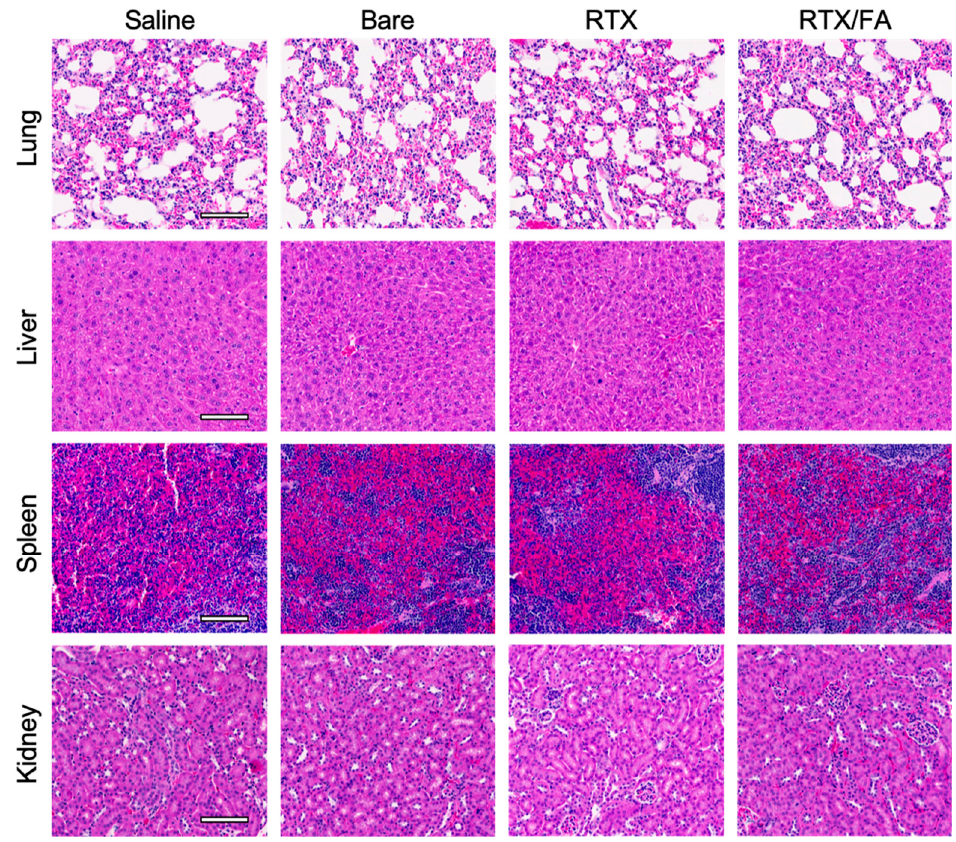
Figure 8. Clearance organ toxicity associated with NP treatments. Images of organs stained with H & E show little to no difference between saline treated animals versus NP treated animals. Scale bar indicates 100 µm.